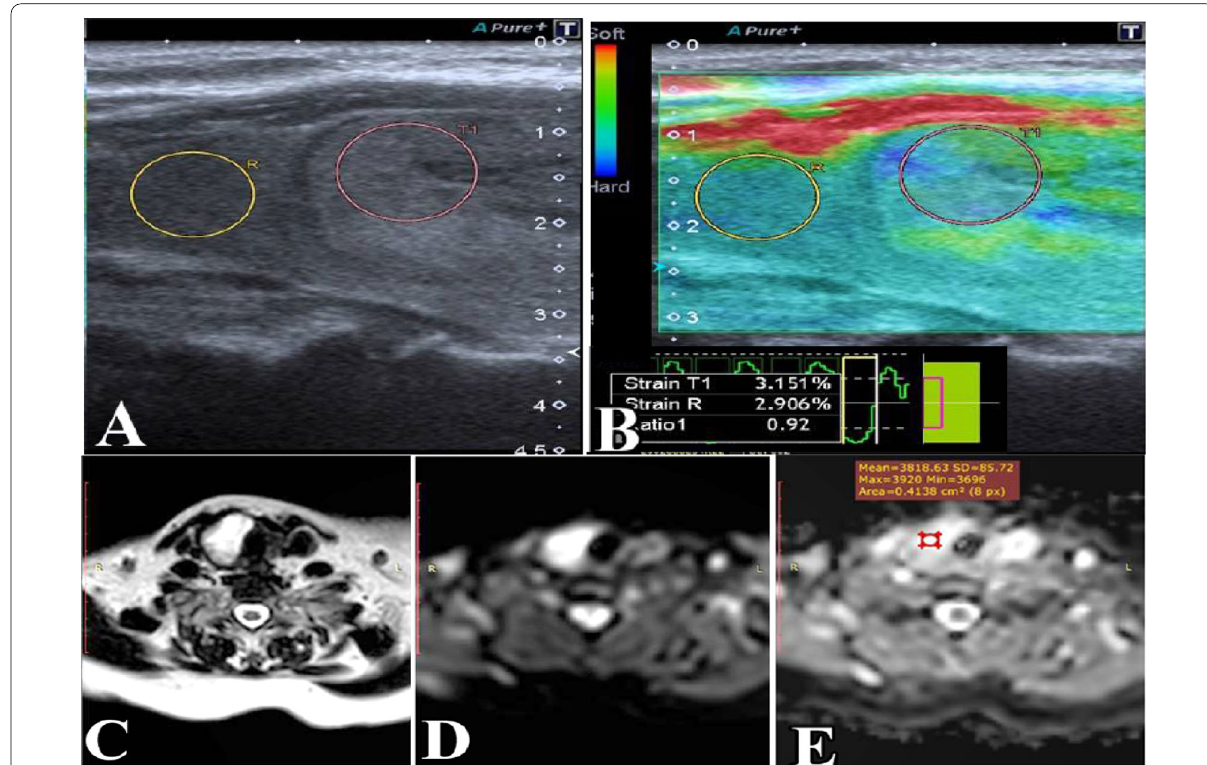
Fig. 2 Female patient aged 50 years presented with right thyroid lobe nodule. Ultrasound features of the module A : The right thyroid lobe shows a solid hyperechoic nodule, wider more than taller with smooth outline. No calcification or echogenic foci. TIRADS categorization: TIRADS (3). On elastography color map B : most of the nodule is shaded with green with small deep blue area. Elastography score: 2. Strain ratio T2 weighted images C : right lobe nodule with mixed high and intermediate signal intensities. Diffusion weighted images D : the nodule shows high signal intensity. ADC mapping E : it shows high signal with ADC value